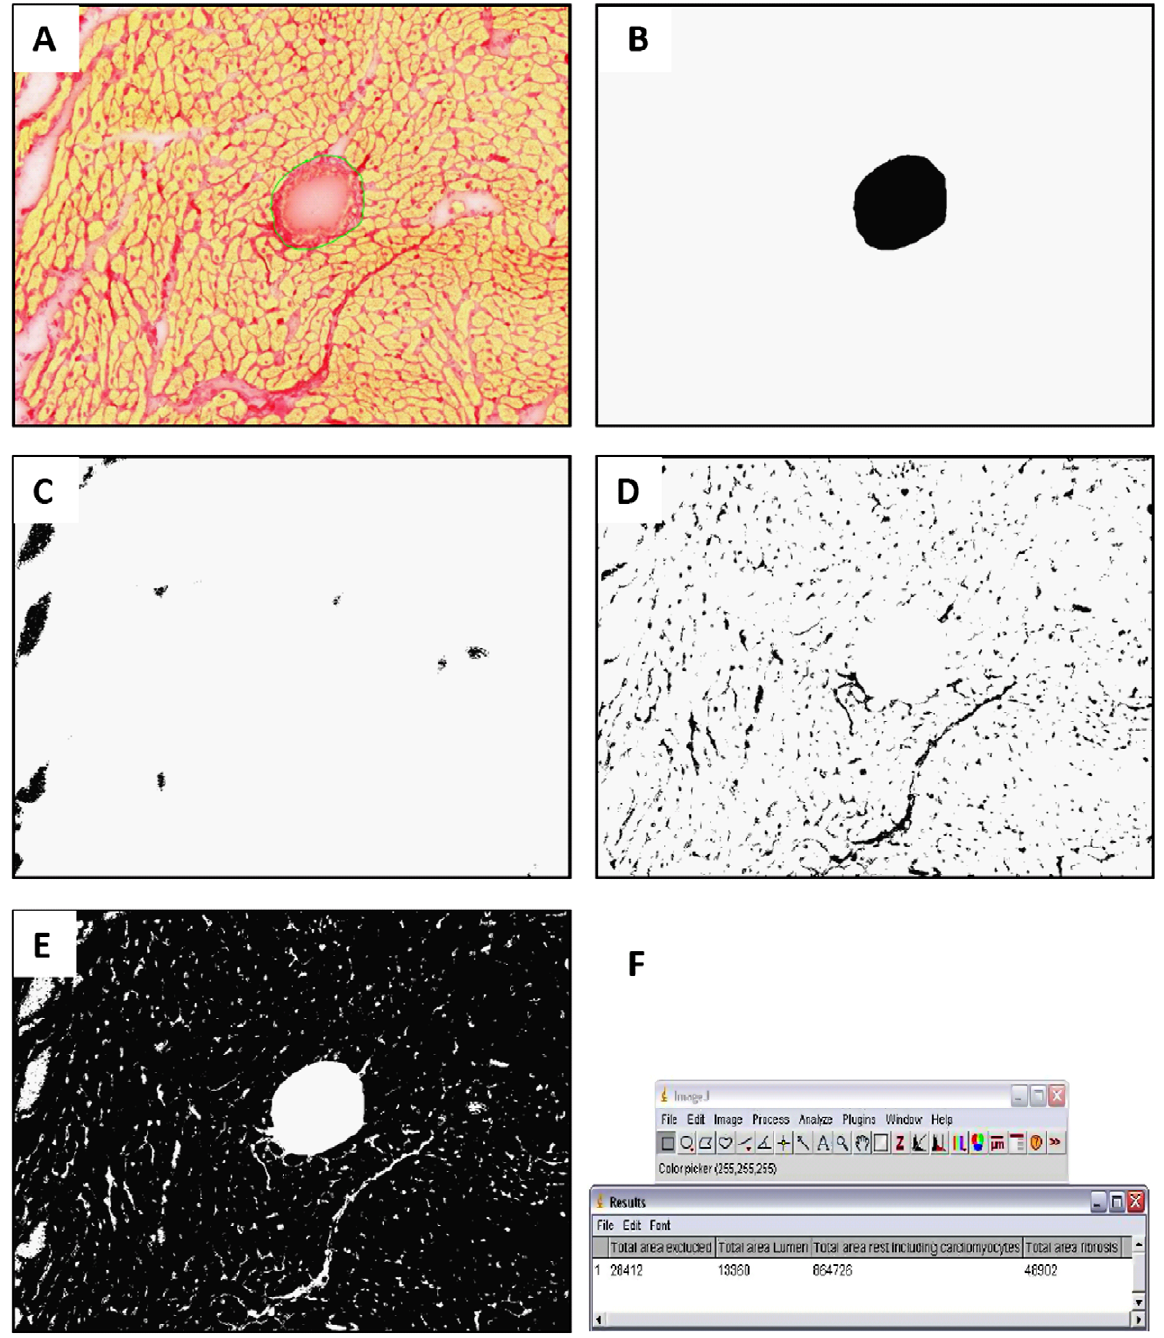
Fig. 2. This figure shows the different steps of the ImageJ macro in identifying different structures in (A) Picrosirius red stained myocardial crossection. (B) First the macro determines the area to excluded which is demarcated by the investigator. (C) Subsequently the areas not occupied by structures are analysed and determined as lumen. (D) The macro then analyses the area occupied by fibrosis and by subtracting these values, the area occupied by (E) cardiomyocytes (in this study; this image contains all tissue compartments left) is determined. At last (F) the results in pixels are presented to the user. (Colors are visible in the online version of the article;